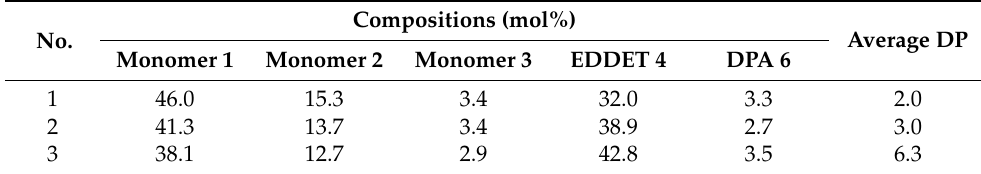
Table 2. Compositions of the oligomers with 25% monomer